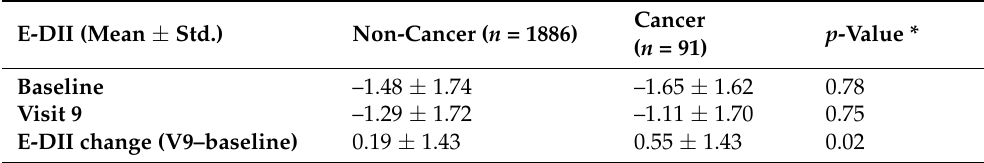
Table 3. Difference in E-DII scores between cancer